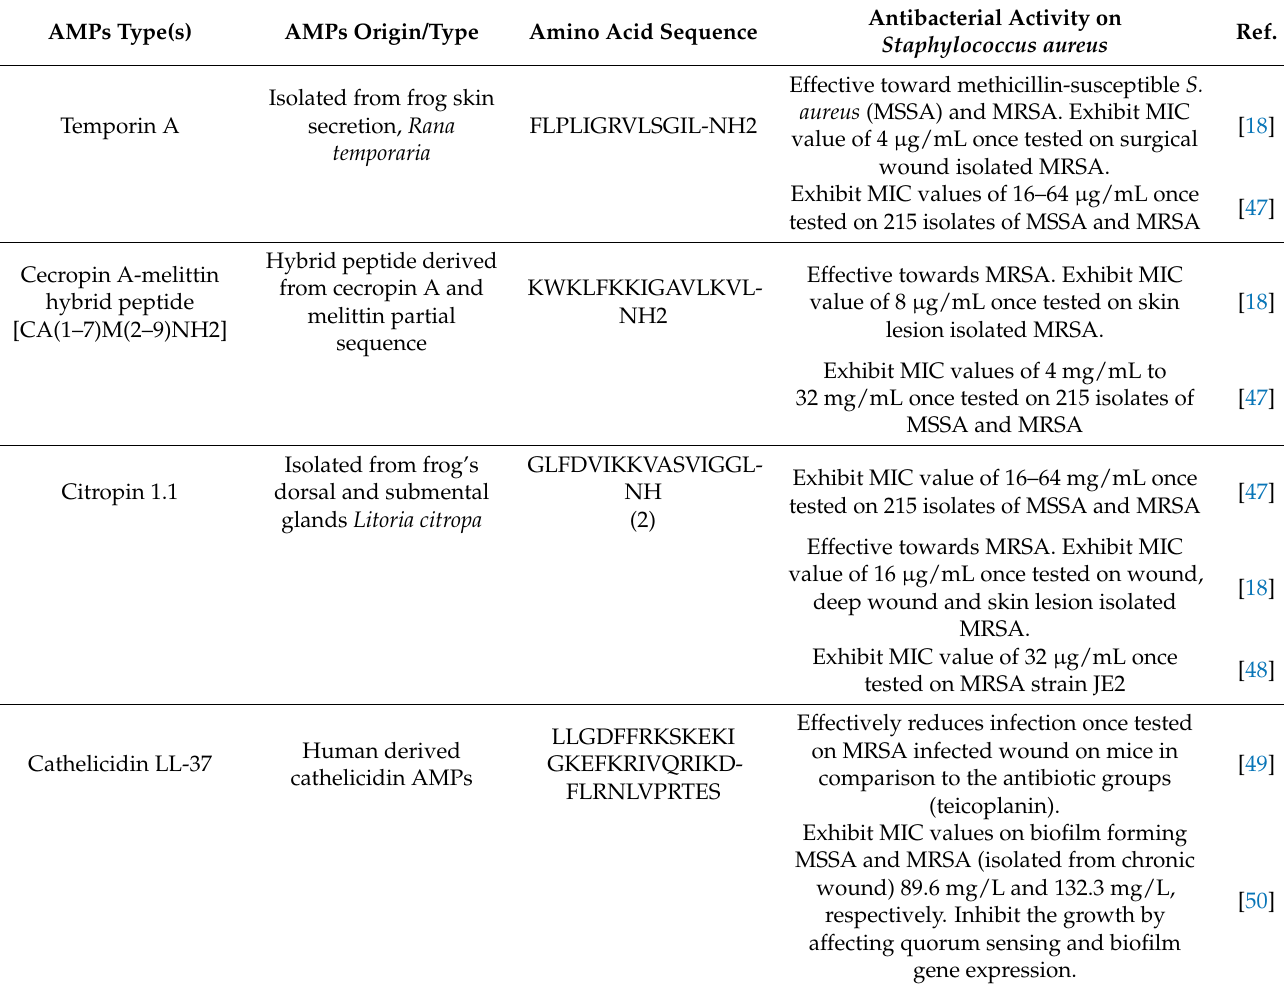
Table 1. Examples of natural antimicrobial peptides that are effective towards Staphylococcus aureus (methicillin-susceptible and